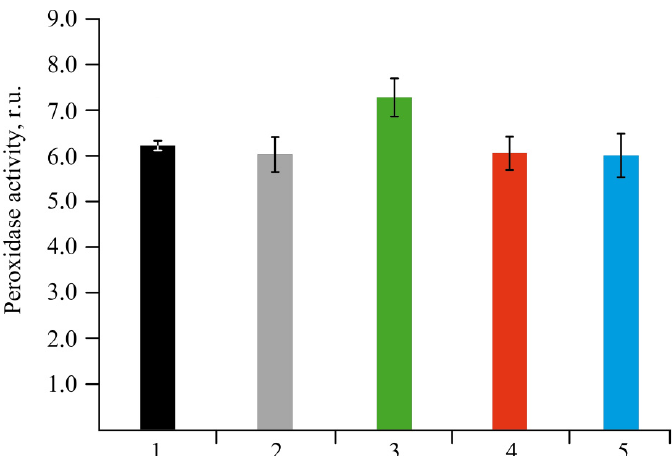
Figure 9. Effect of NC treatments on the peroxidase activity in potato plants in comparison with the control group in vitro; (1)—control, (2)—without Mn sulfate in medium, (3)—AG-Mn, (4)—AGS- Mn, (5)— κ -CG-Mn. The treated plants were not different from the control according to the Mann–Whitney test.